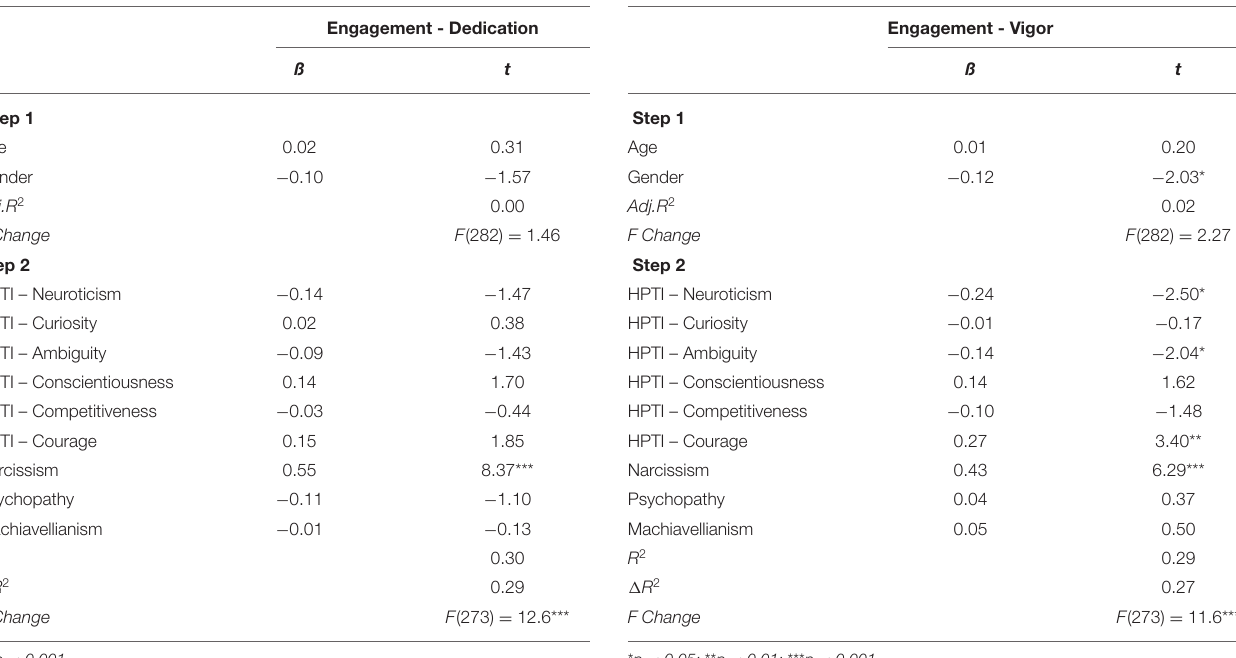
TABLE 3 | Regression of HPTI and Dark Triad on UWES Dedication. TABLE 4 | Regression of HPTI and Dark Triad on UWES Vigor.